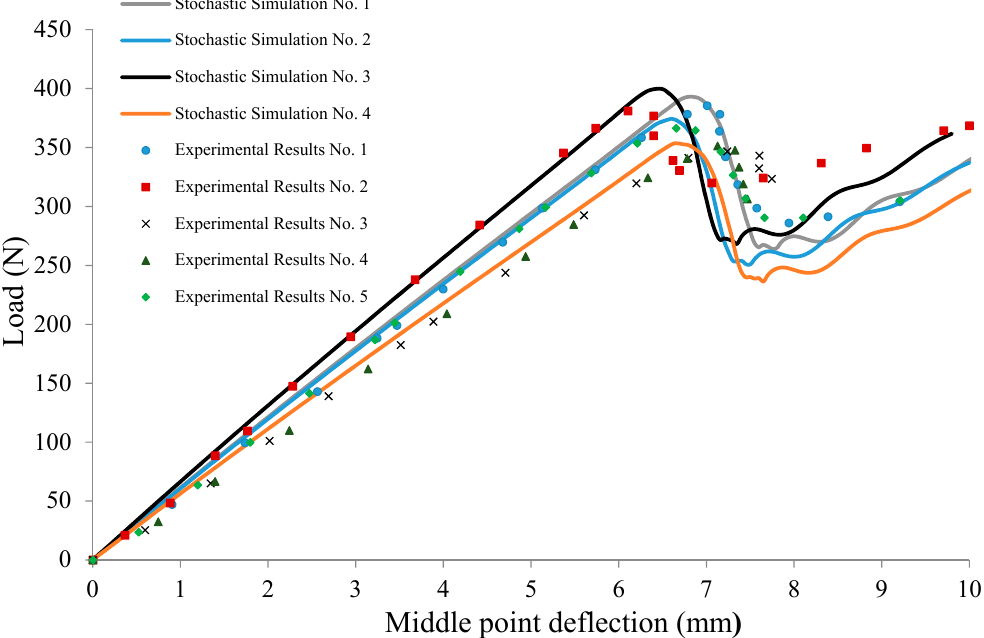
Figure 7. Comparison of stochastic measured and predicted force–displacement values in ENF tests on the polyphenylene sulfide (PPS)/glass samples.